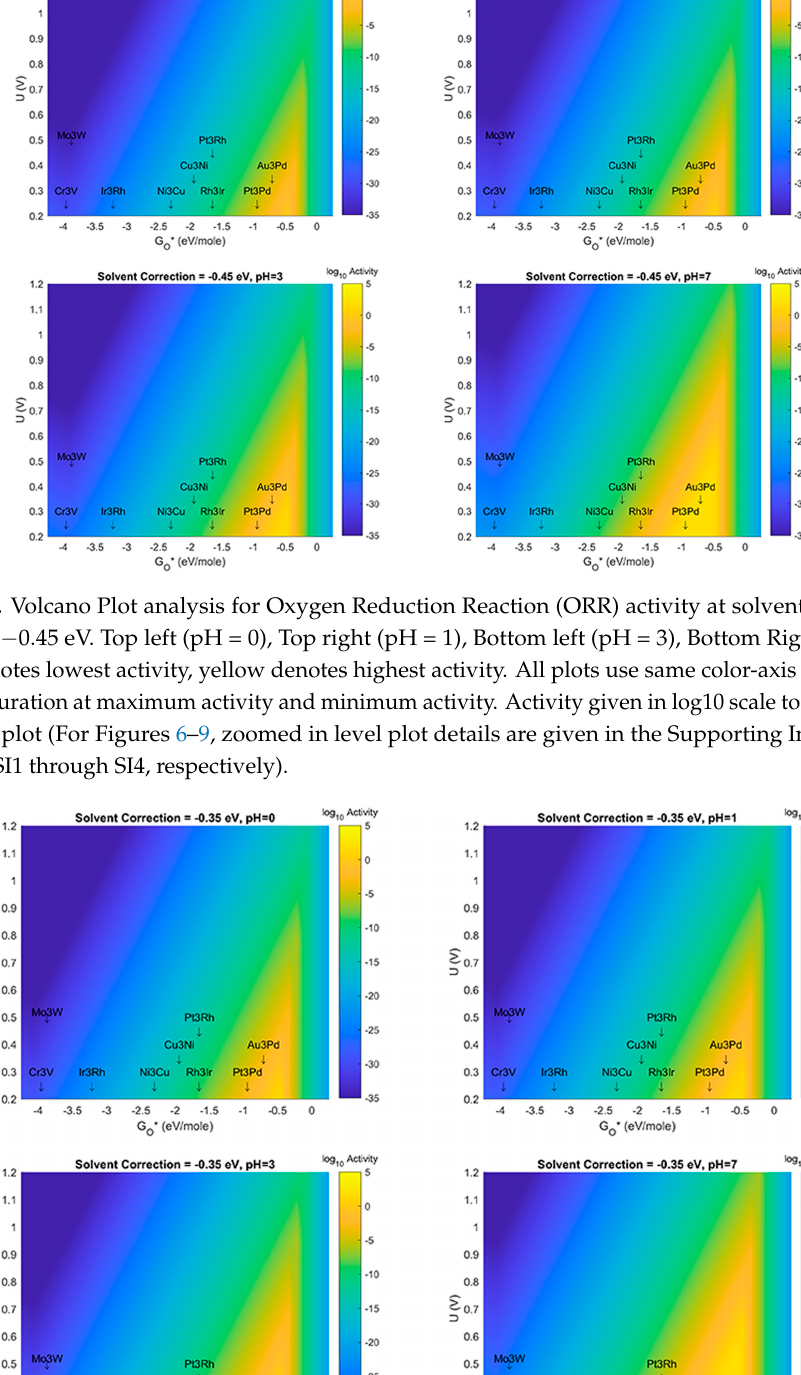
Figure 8. Volcano Plot analysis for ORR activity at solvent correction value of –0.20 eV. Top left (pH = 0), Top right (pH = 1), Bottom left (pH = 3), Bottom Right (pH = 7). Blue denotes lowest activity, yellow denotes highest activity. All plots use same color-axis scale hence some saturation at maximum activity and minimum activity. Activity given in log10 scale to show more detail in plot.